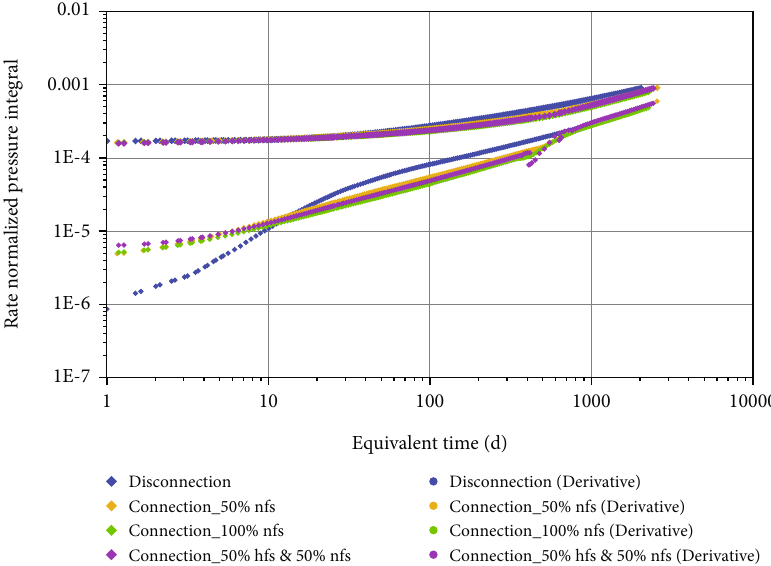
Figure 9: Log-log type curves of di ff erent well connection conditions considering both hydraulic fractures and natural fractures.